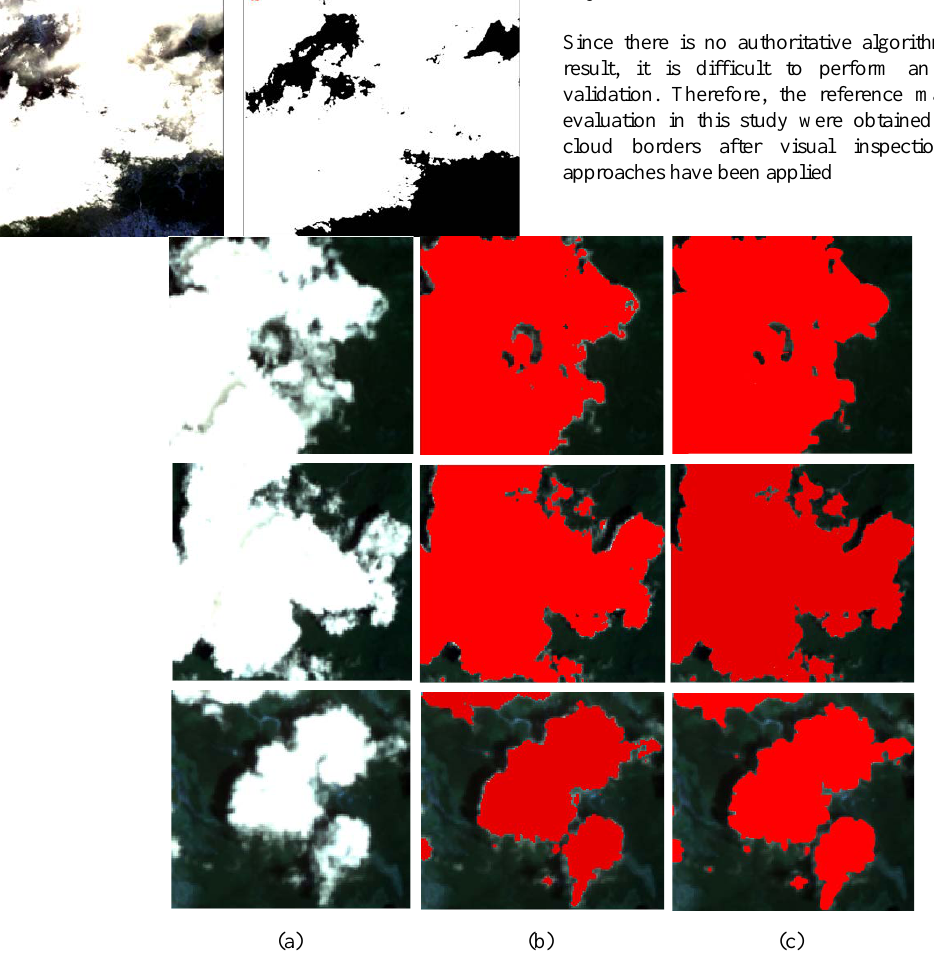
Fig.6.Example of BOTF cloud masks. (a) Original true color image (red, green and blue bands). (b) The results of cloud detection. (c) The real